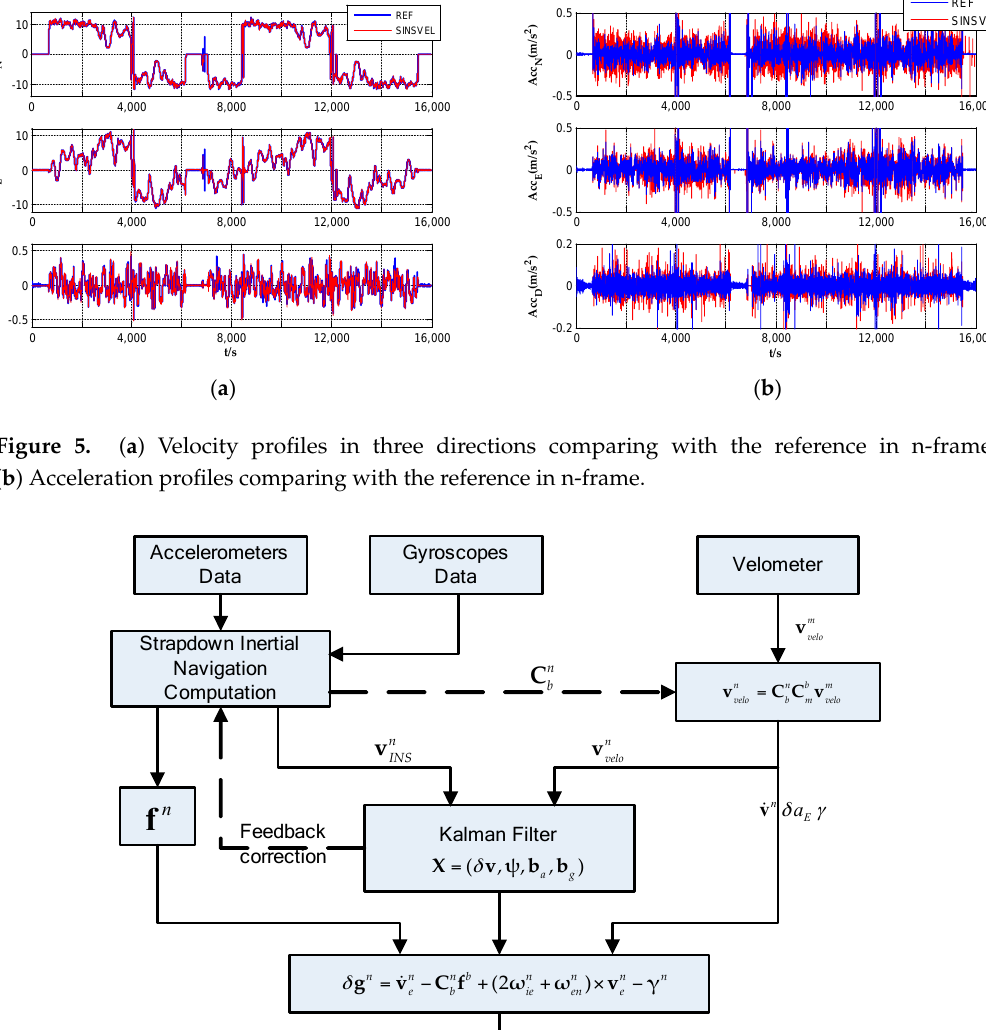
Figure 6. Data processing flow diagram.